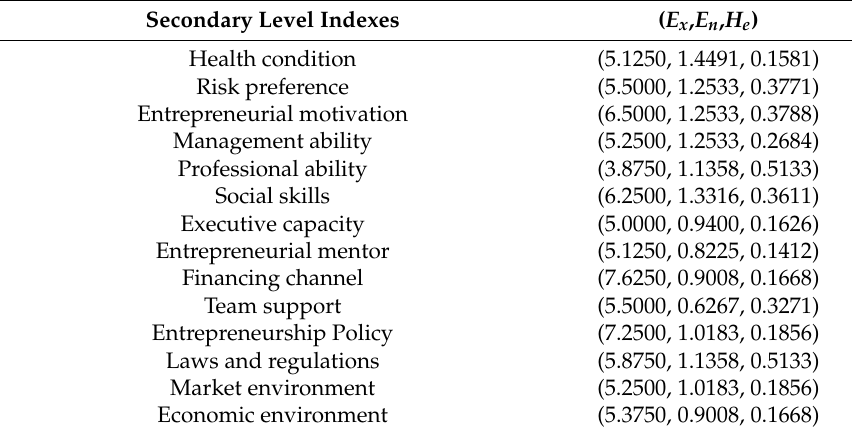
Table 5. The cloud model (CM) of secondary level indexes.